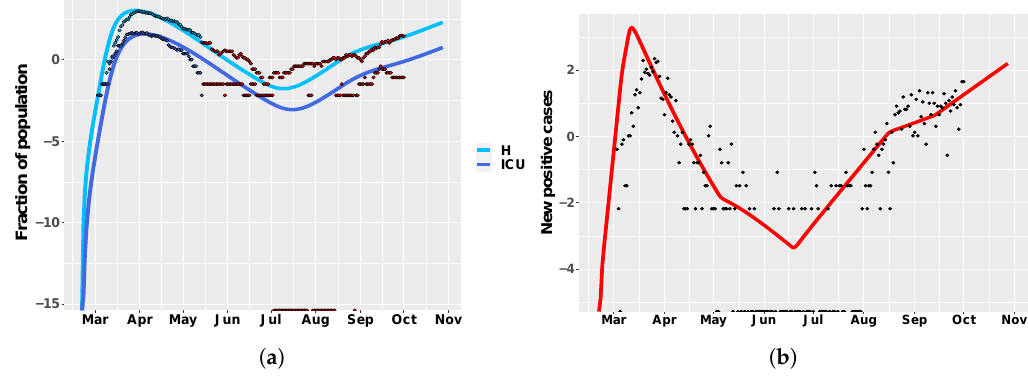
Figure 8. Umbria. ( a ) time behavior of hospitalized (light blue) and ICU (blue) patient in comparison with data of the Italian Civil Protection Department [21]. Data in red represent the second portion of the available dataset, from 4 May until 1 October 2020, which were not employed in model calibration. The newly introduced intervention parameters are set to: s 03 = 0.15, s 04 = 0.15, s 05 = 0.27, s 06 = 0.22, s 07 = 0.25. ( b ) Umbria: time evolution of new positive cases in comparison with the data in